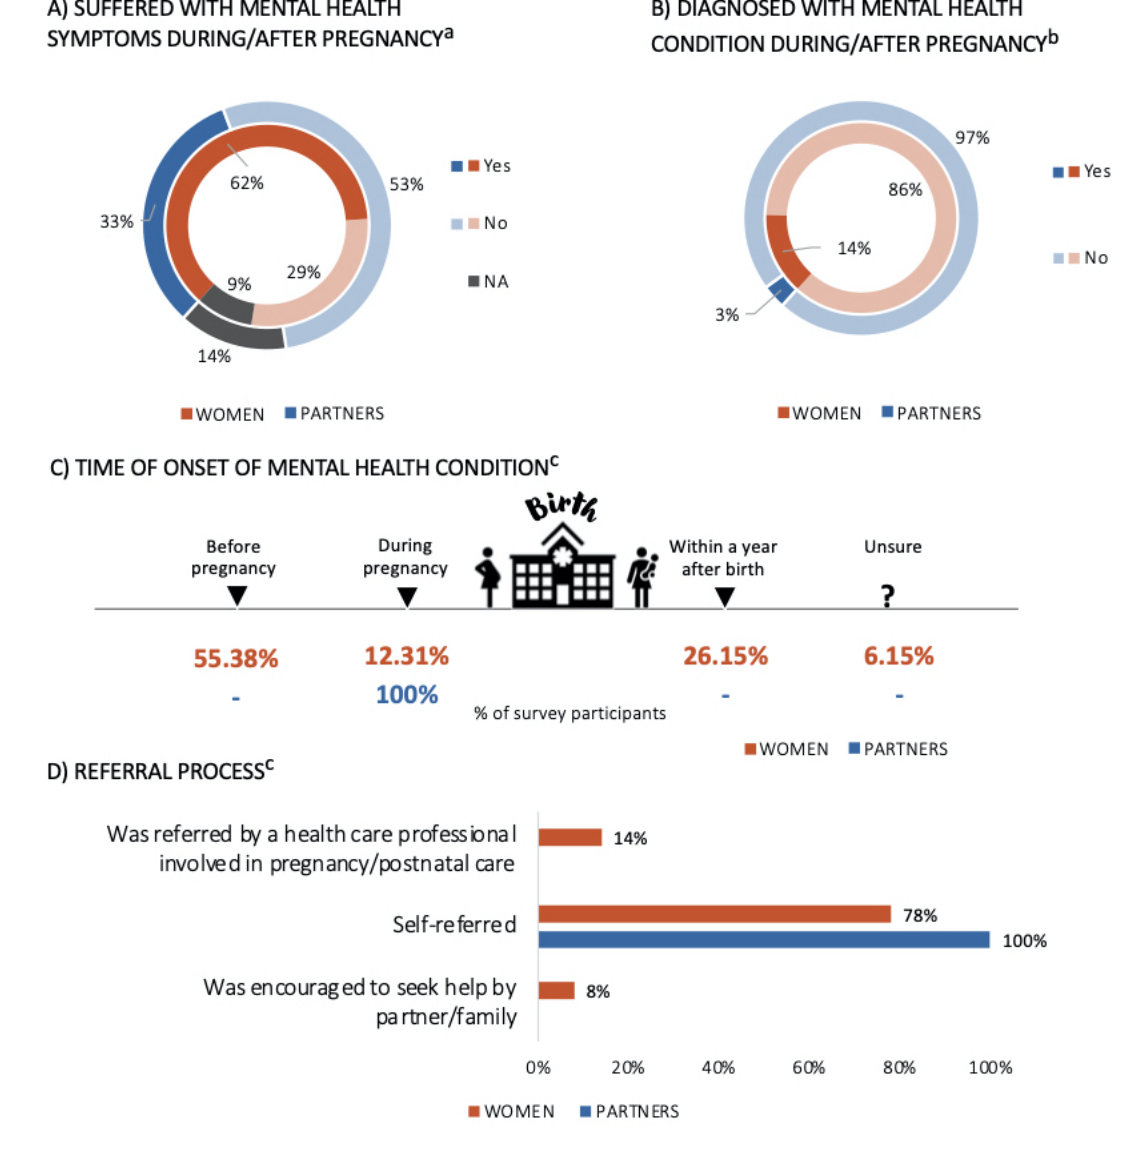
Figure 4. Mental health symptoms and diagnoses for women and partners, including whether they had experienced mental health symptoms during or after the pregnancy (A), whether they had been diagnosed with a mental health condition during or after the pregnancy (B), the time of onset of the mental health condition (C), and information regarding the referral process (D). a: Includes those who are pregnant or have given birth (women: n=753; partners: n=92); b: Includes those who answered “yes” to experiencing mental health symptoms during or after pregnancy (women: n=469;